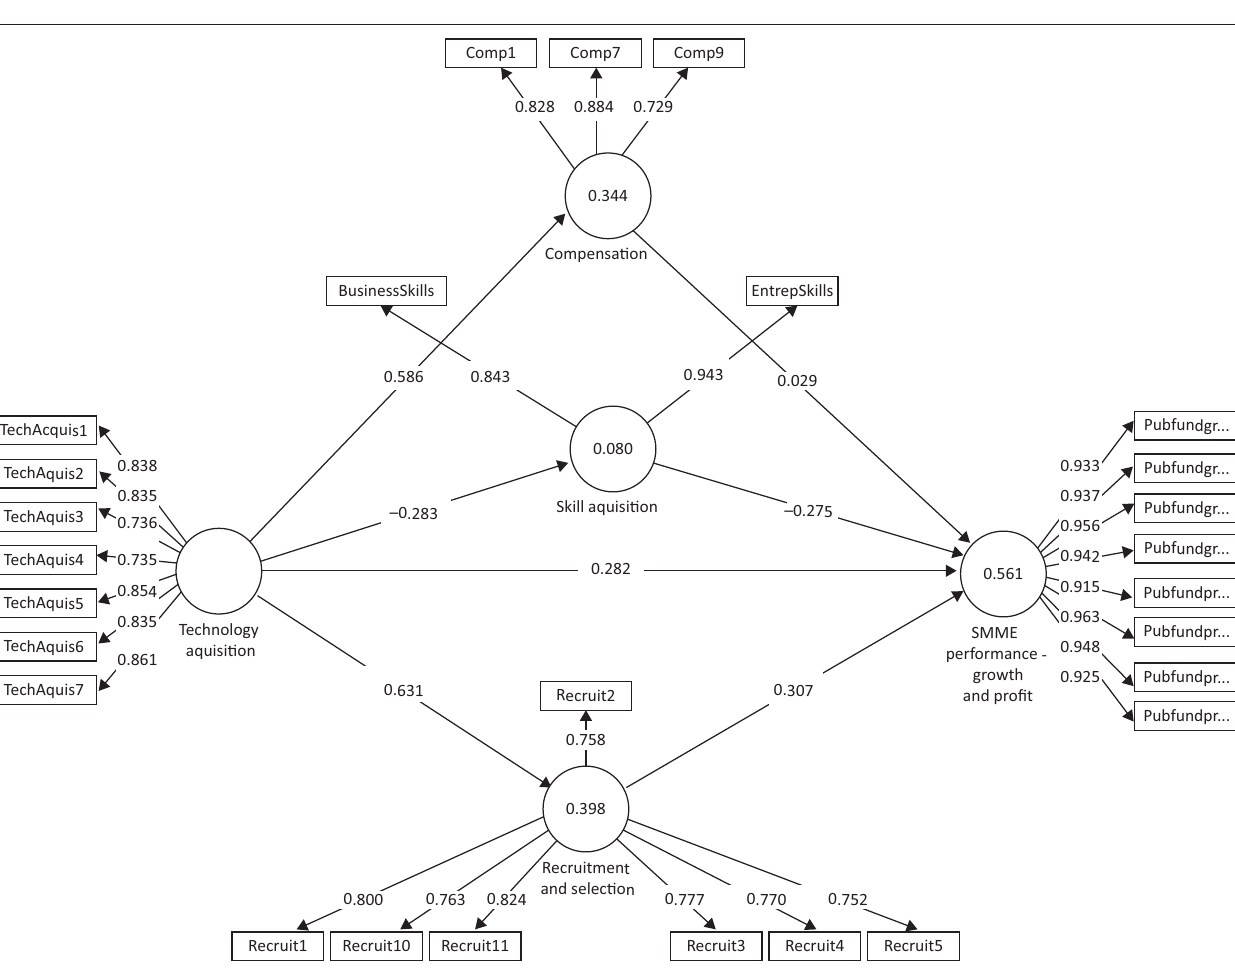
FIGURE 3: The results of the structural model when technical skills are replaced by general business skills. TABLE 5: Summary of the total, total indirect and specific indirect effects. Type